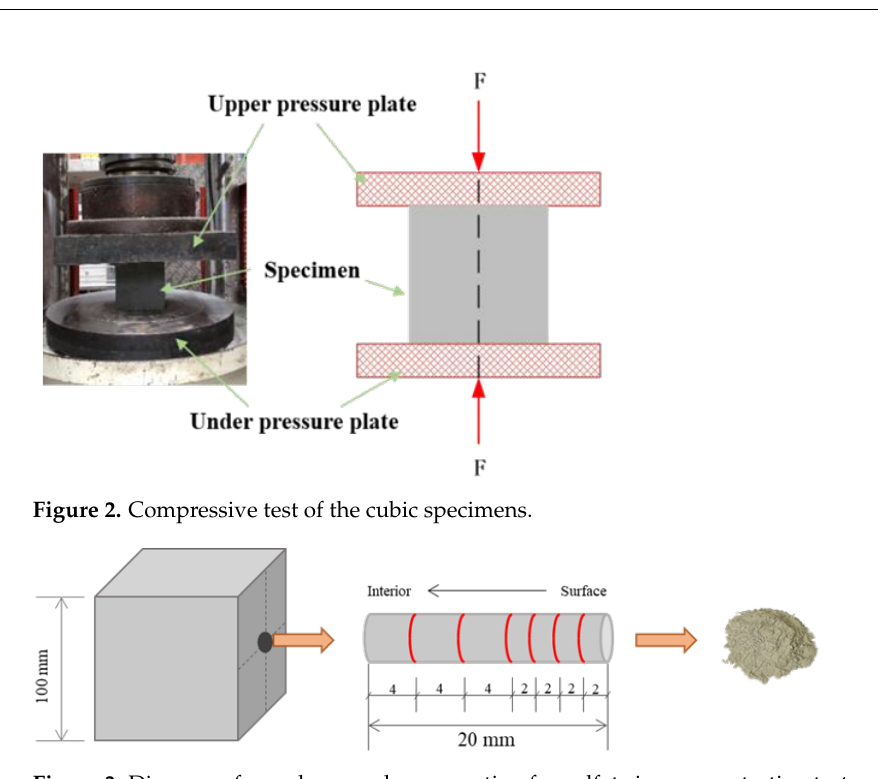
Figure 3. Diagram of powder sample preparation for sulfate ion concentration test.